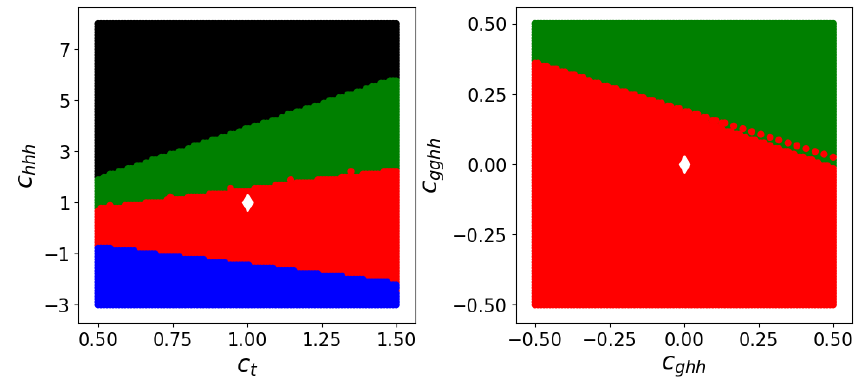
Figure 2 . The parameter regions leading to each prede(cid:12)ned shape type in the c t (cid:0) c hhh (left) and c ggh (cid:0) c gghh (right) parameter spaces. The black area denotes shapes of kind 1 (enhanced low m hh region; green: kind 2 (well separated double peaks), red: kind 3 (SM-like), blue: kind 4 (close-by double peaks). The white diamonds mark the Standard Model